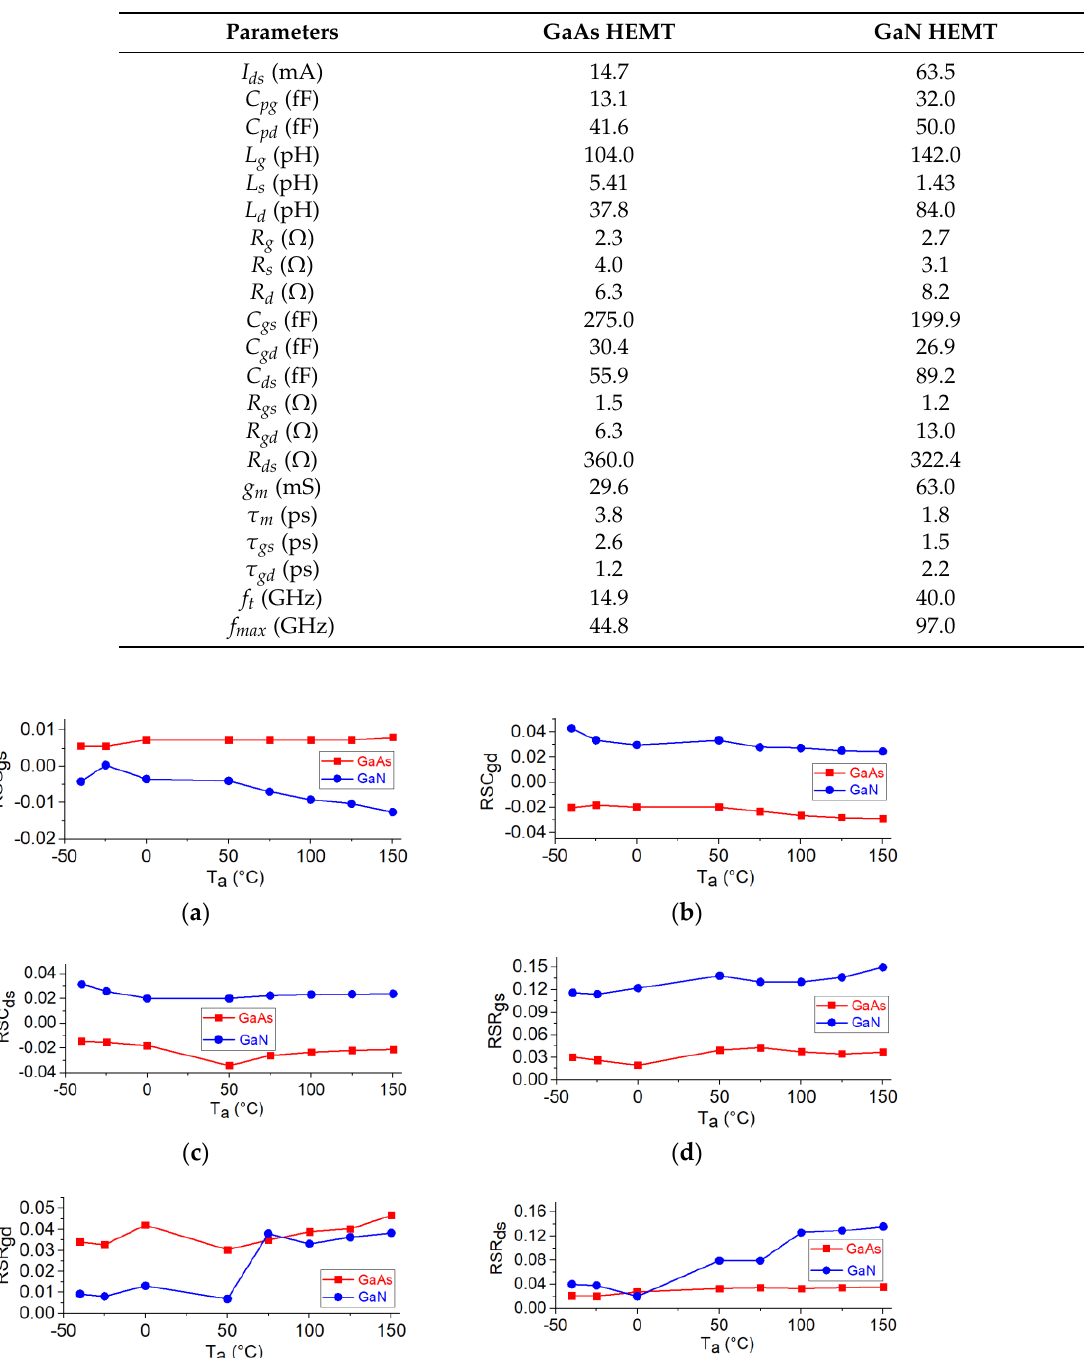
Table 1. Parameters for GaAs and GaN HEMTs at 25 ◦ C.